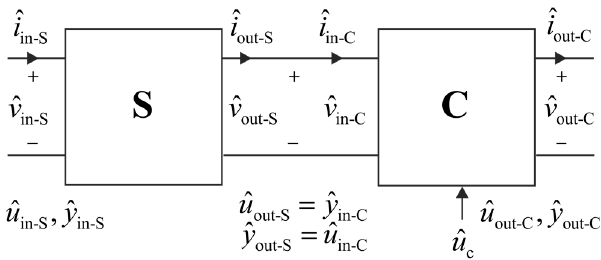
Figure 14. Cascaded source (S)-converter (C) system.